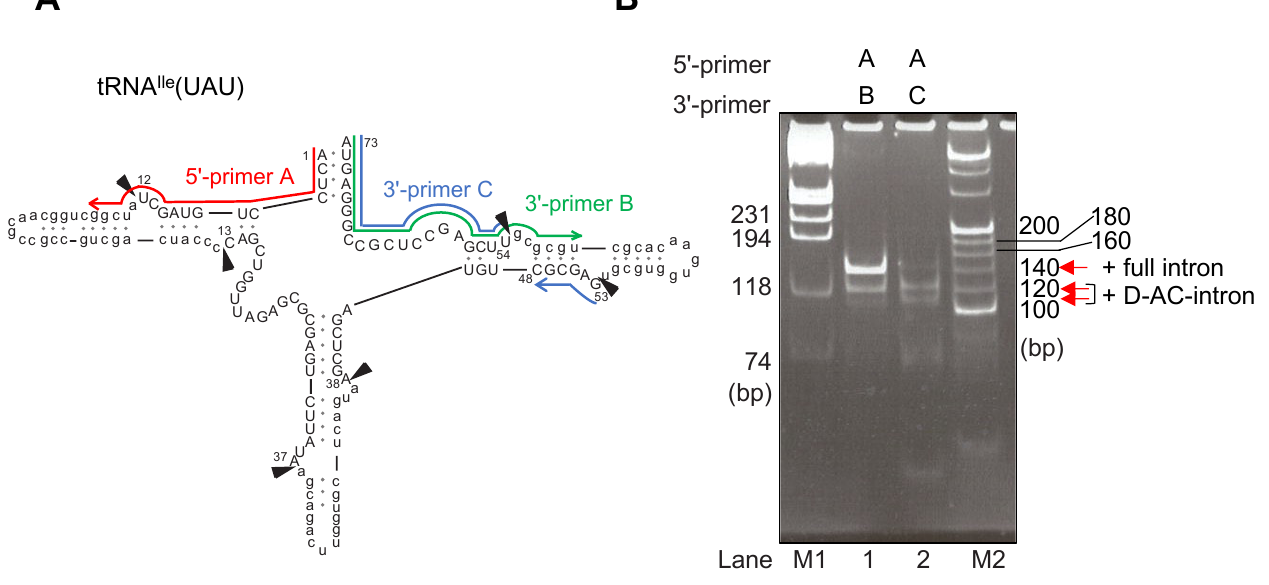
Figure 7. RT-PCR amplification of processing intermediates of C. merolae tRNA Ile (UAU). ( A ) The inferred secondary structures of the precursor of tRNA Ile (UAU) with three introns, one at 12/13 in the D-arm, one at 37/38 in the anticodon arm, and the third at 53/54 in the T-arm. Arrowheads indicate the positions to be processed. Intron sequences are shown in lowercase. ( B ) Processing intermediates of tRNA Ile (UAU) were amplified with 5 (cid:48) -primer A (red arrow) and 3 (cid:48) -primer B (green arrow) or 3 (cid:48) -primer C (blue arrow) for RT-PCR. PCR products amplified from the cDNA of precursors and processing intermediates are indicated. The sizes of RT-PCR products are as follows: 146 bp for pre-tRNA Ile (+ full intron); 126 bp for pre-tRNA Ile (+D-AC-intron). Lane M1: DNA molecular marker ( ϕ X174/Hae III, NEB). Lane M2: DNA molecular marker (20 bp Ladder, Takara,